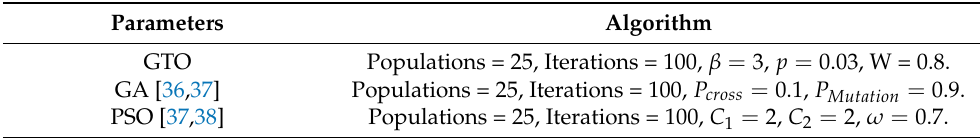
Table 1. The selected parameters for GTO, GA and PSO. Parameters Algorithm